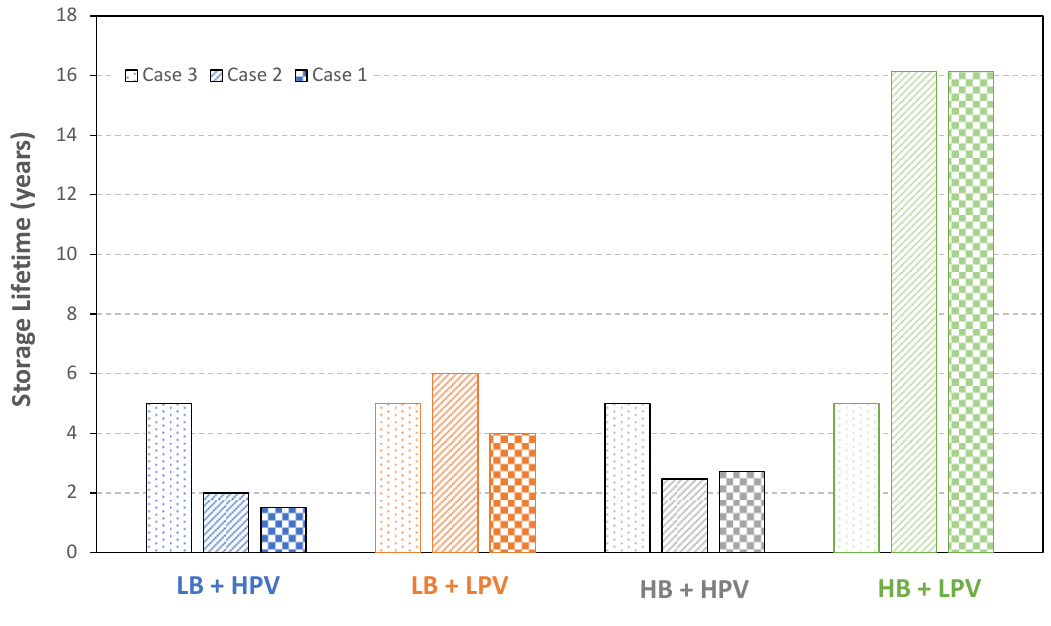
Figure 9. Battery lifetime for all scenarios.